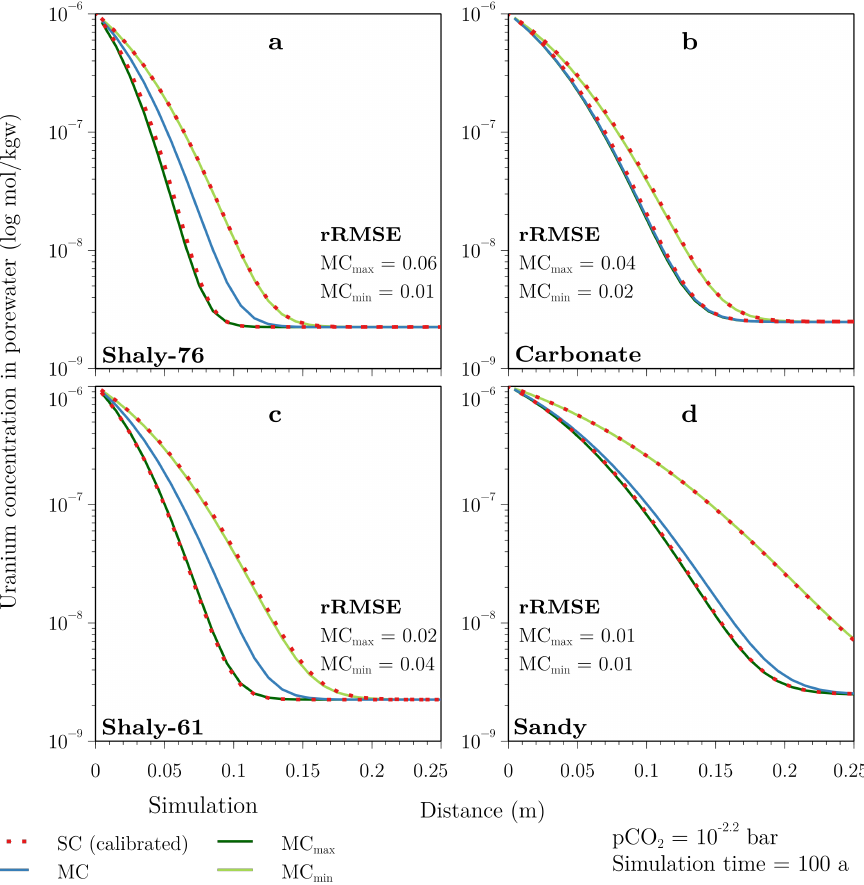
Figure 5. Concentration of uranium in the porewater of the shaly ( a , c ), carbonate-rich ( b ) and sandy facies ( d ) for the scenarios with minimum (MC min , 12–13 kg rock /kg pw , light, green line), maximum (MC max , 15–18kg rock /kg pw , dark, green line) and average (MC, 14–17kg rock /kg pw , blue line) total amount of rock per kg porewater. The red, dotted lines represent the results of the simulations based on the SC approach with the K d and D e calibrated from the MC